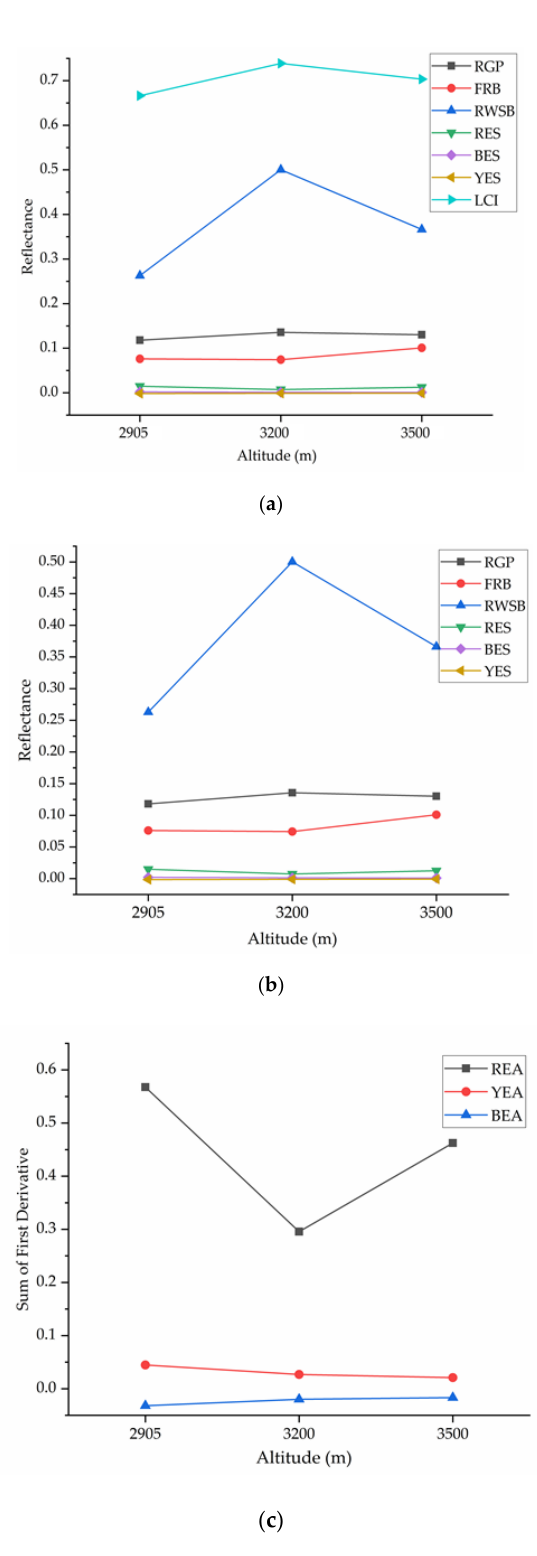
Figure 6. Spectral parameters of Quercus aquifolioides leaves at different altitudes. ( a ) spectral position, ( b ) spectral reflectance, ( c ) spectral area parameter. REP (red edge position), RES (red edge slope), BEP (blue edge position), BES (blue edge slope), YEP (yellow edge position), YES (yellow edge slope), RVP (red valley position), RRV (reflectance of red valley), GPP (green peak position), RGP (reflectance of green peak), RWSB (reflectance of water stress band), REA (red edge area), YEA (yellow edge area), BEA (blue edge